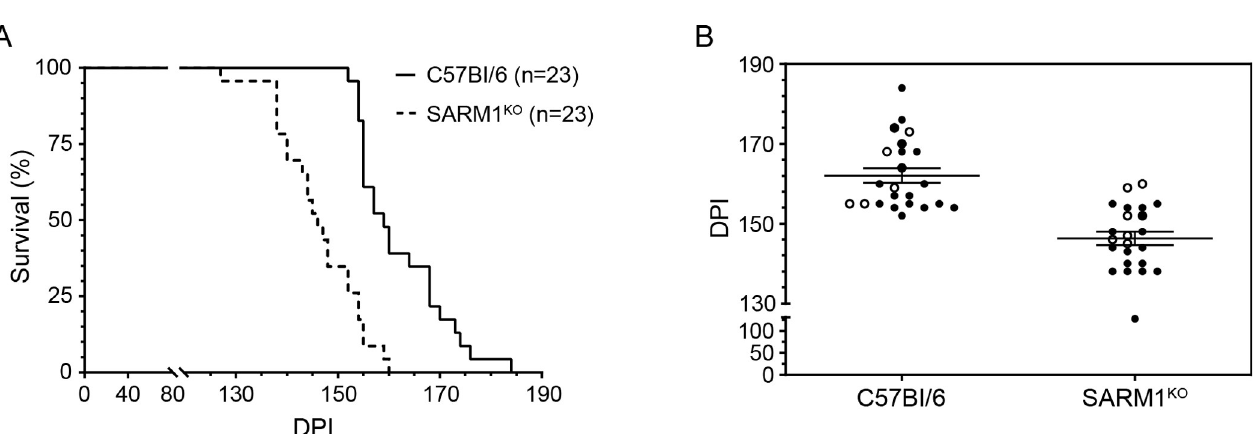
PLOS ONE | https://doi.org/10.1371/journal.pone.0267720 May 4,